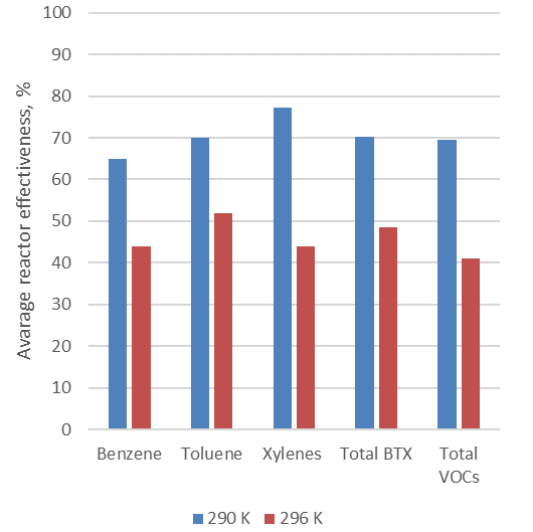
Fig. 5. Average photocatalytic system effectiveness, temperature compari-